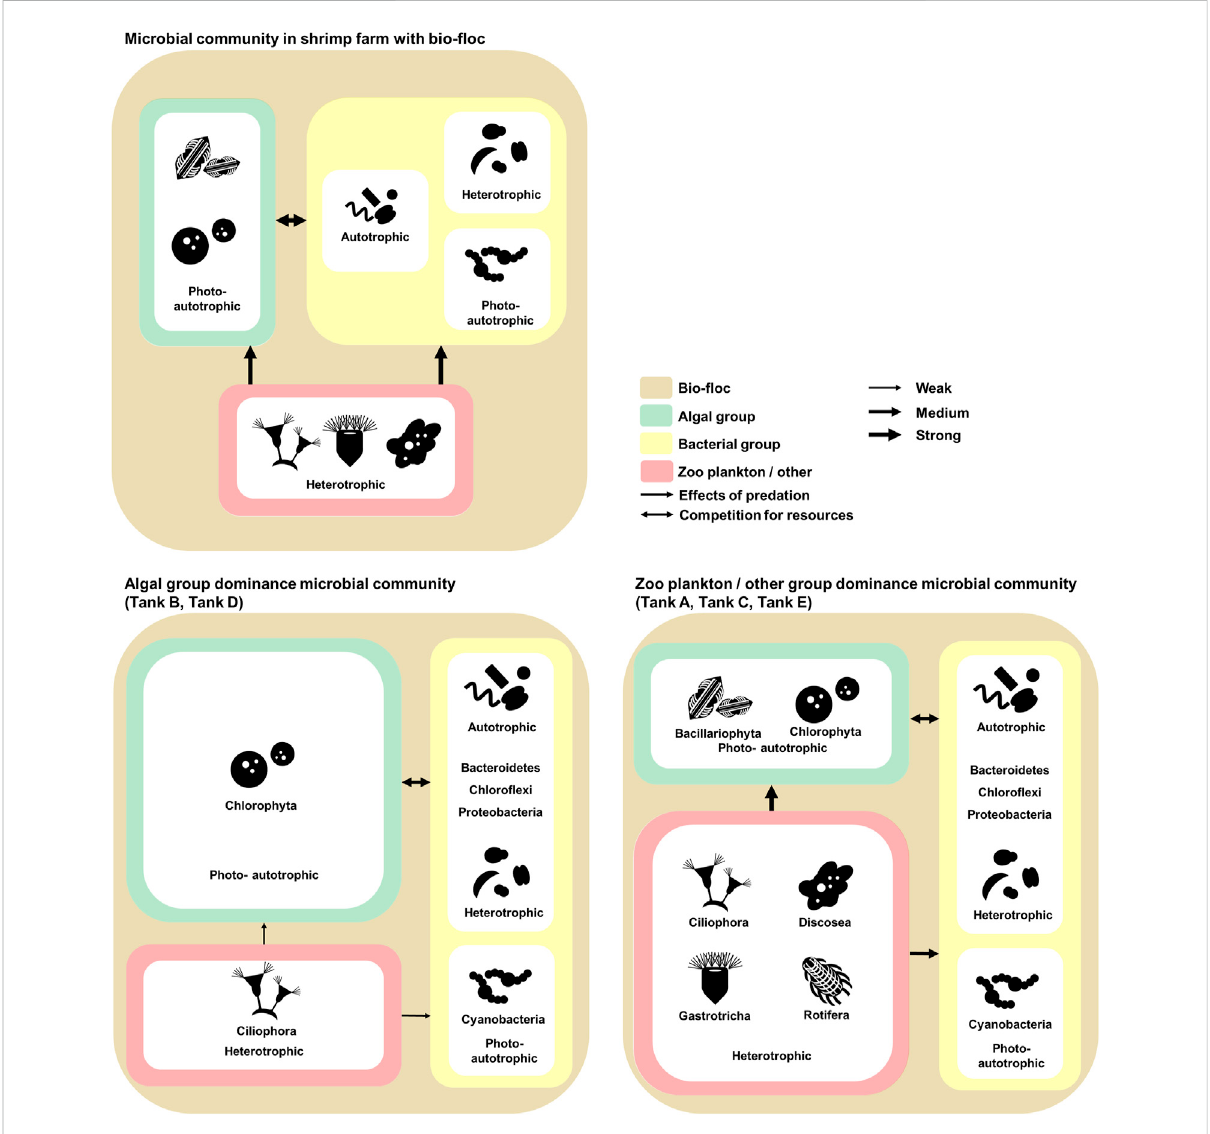
FIGURE 5 Theinvestigatedmodelofrelationshipsandcommunicationsinthemicrobialcommunitiesof Litopenaeusvannamei shrimpfarmswithbio fl oc technology. The microbial communities coincide with bio fl oc technology. The environmental features of the aquatic environment in the shrimp farms. The data underlying all the diagrams indicated in this fi gure can be found in Table 2 and Supplementary Tables S1,